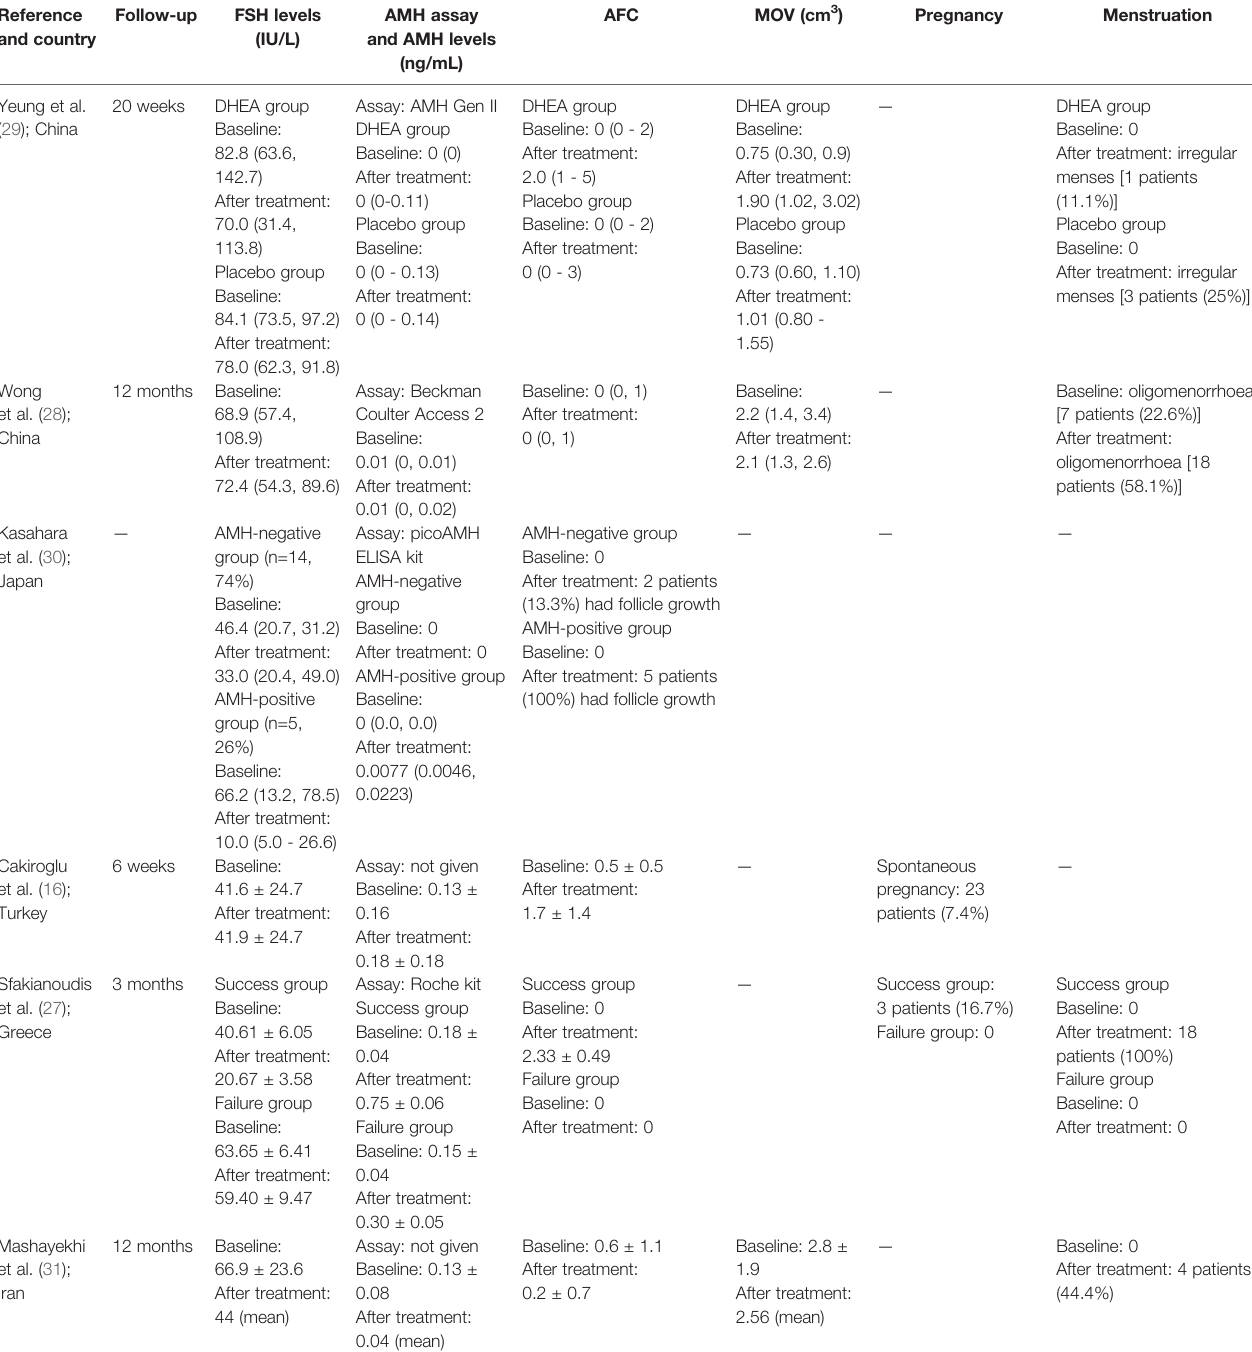
TABLE 2 | Ovarian function evolution of patients of the six studies included in the review. Reference and country